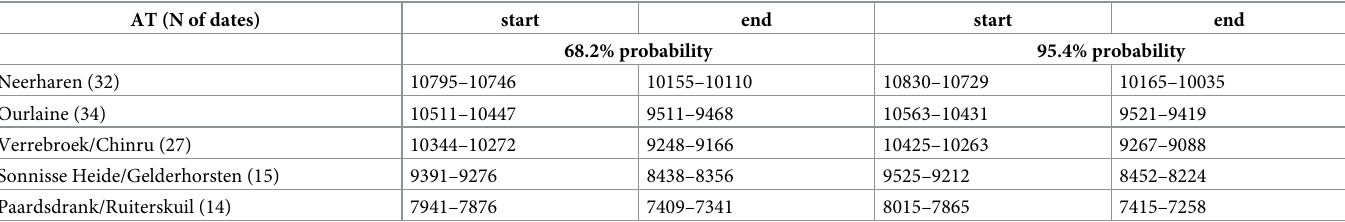
Table 2. Results of the Bayesian “Phase” modelling (model 3; A overall 80.6%). AT (N of dates) start end start end 68.2% probability 95.4%